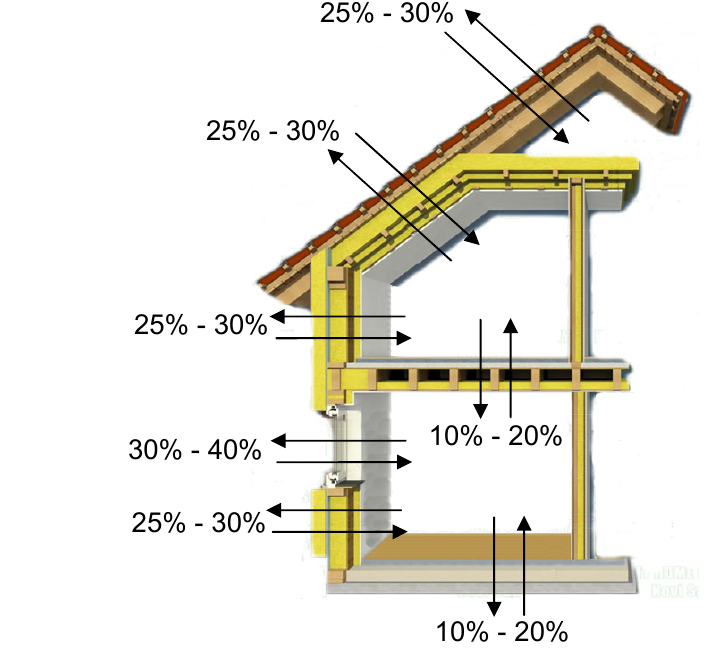
Рис .3 – Теплопотери через строительные конструкции здания Figure 3 – Heat losses through the building structural